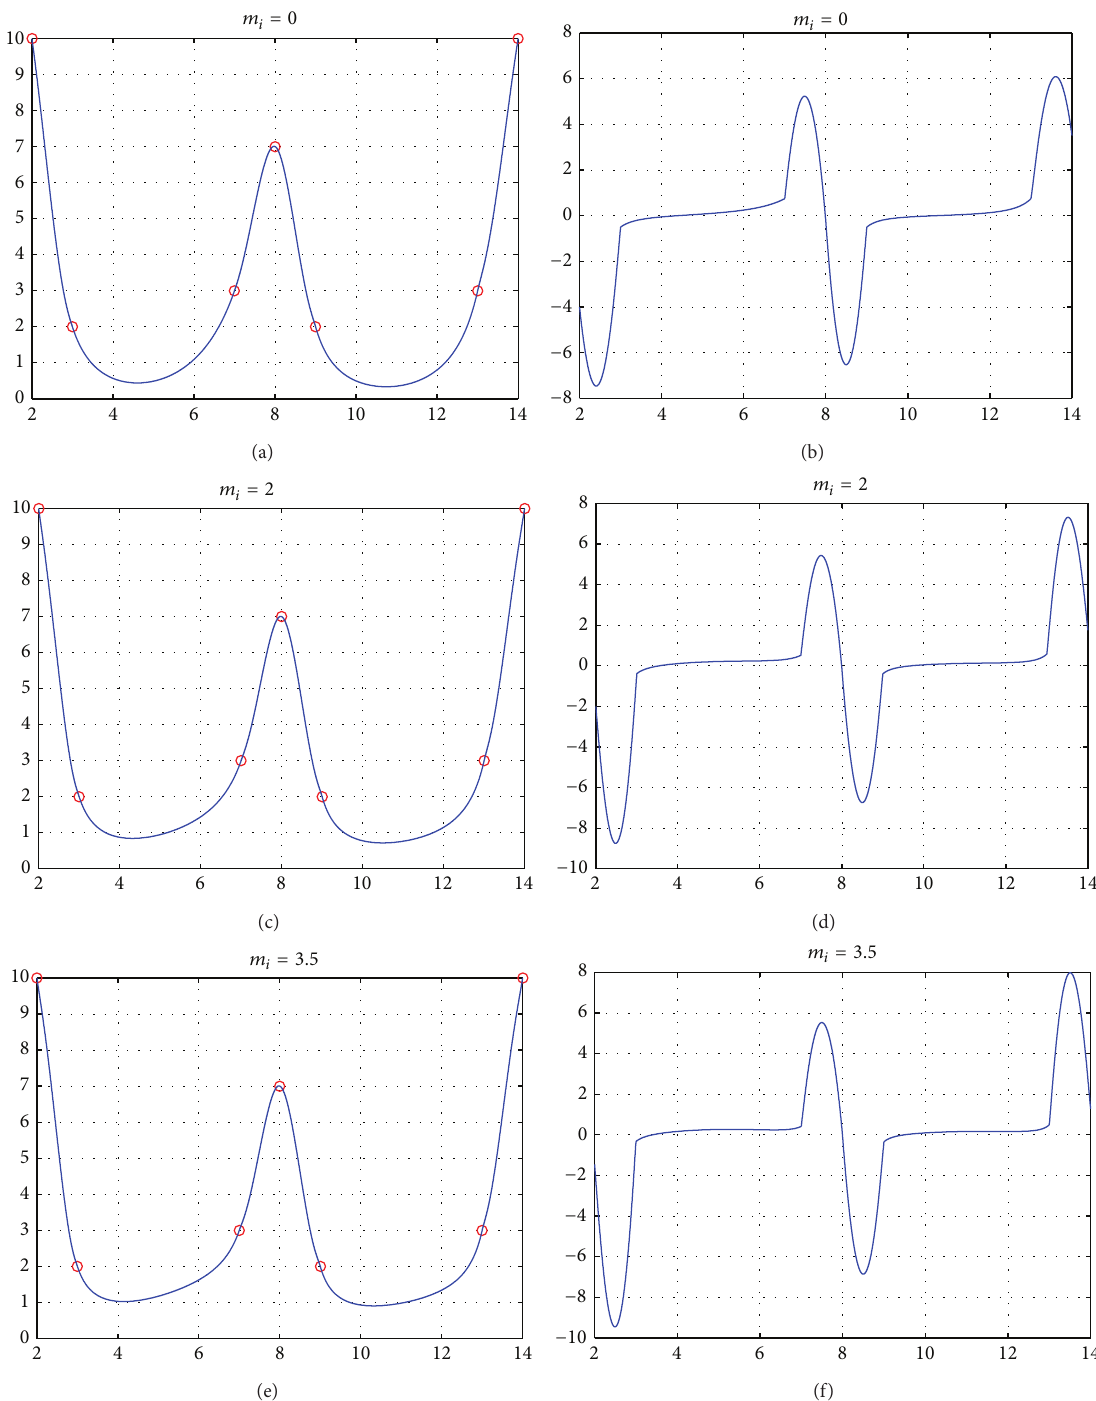
Figure 6: Positivity-preserving interpolation spline curves for the dataset given in Table 1 and the graphics of their first derivatives.